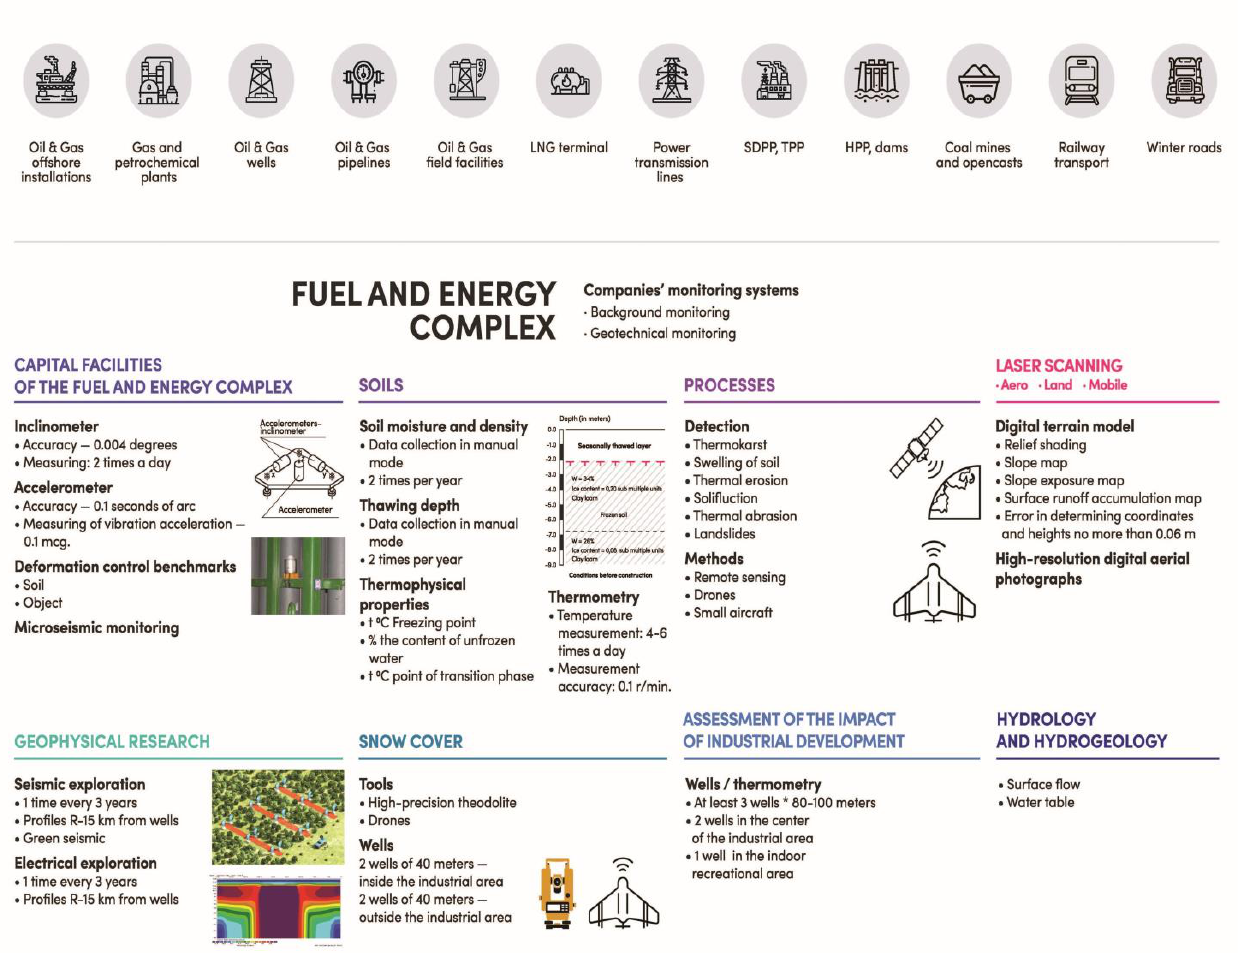
Figure 4. Permafrost monitoring structure.